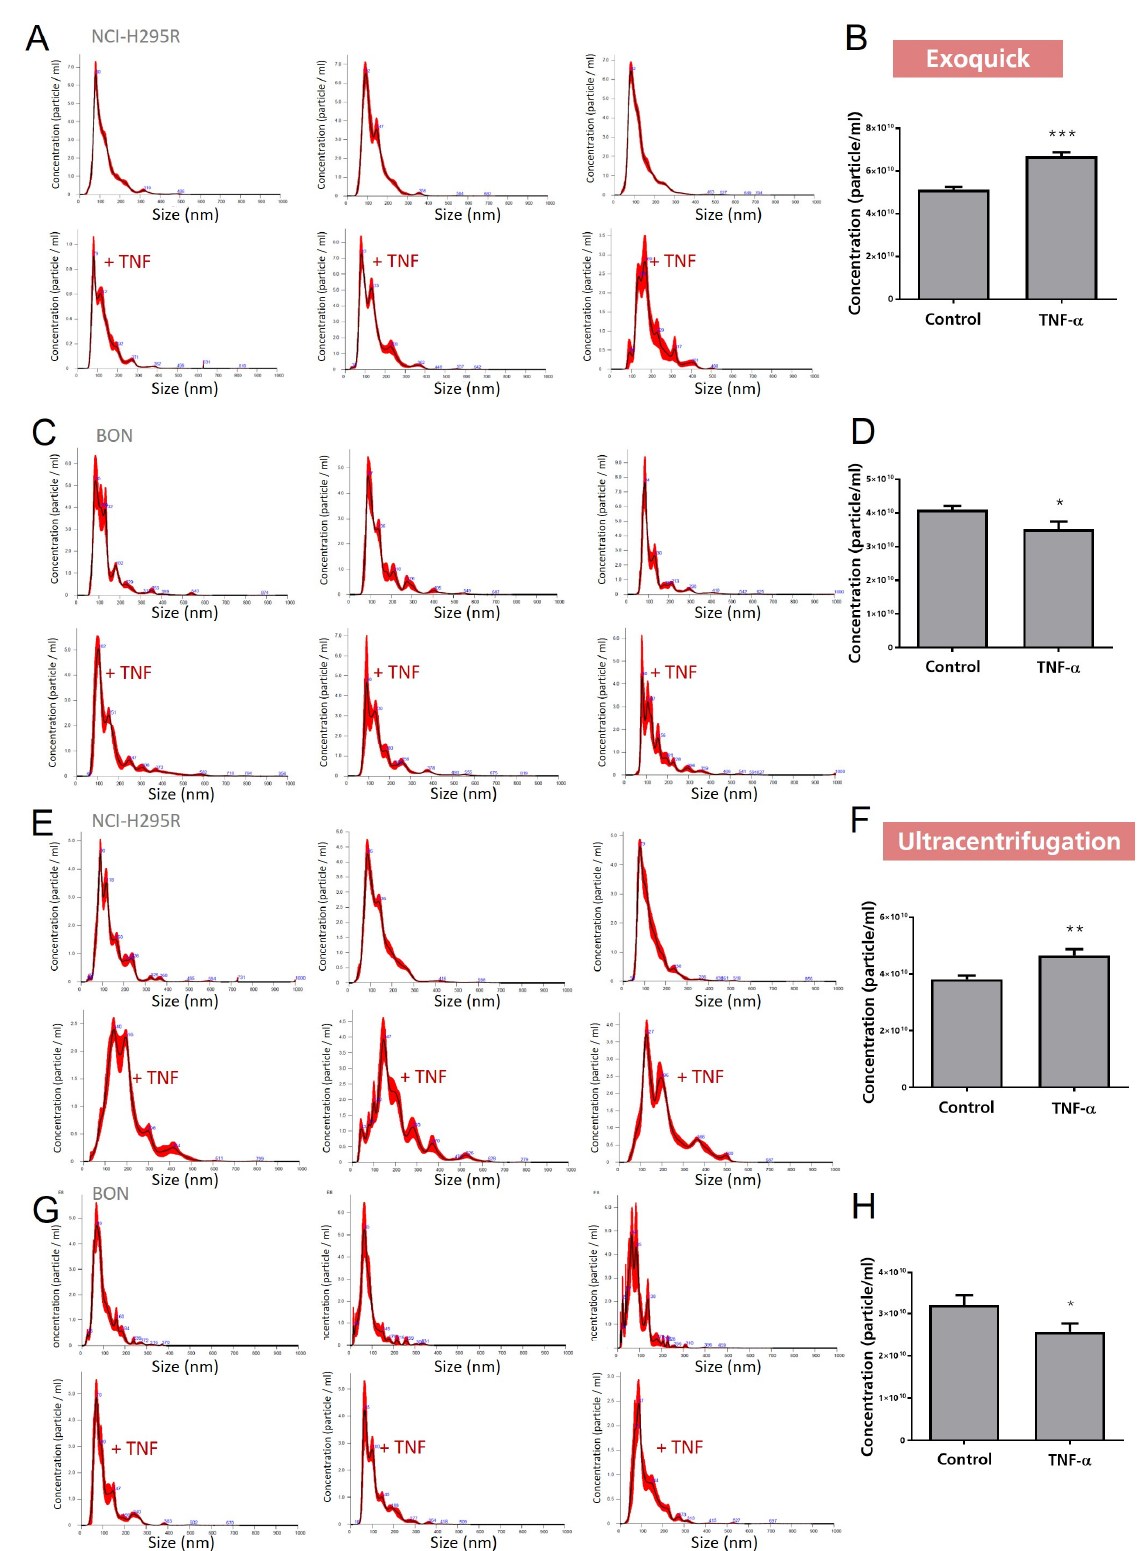
Figure 3. Nanoparticle tracking analysis including size distribution ( A , C , E , G ) and quantification of exosomes isolated by either ExoQuick ( B , D ) or ultracentrifugation ( F , H ) from cell culture supernatants of TNF α -treated BON and NCI-H295R cells. The statistical significance is based on paired t-tests vs. controls and is denoted as stars (* p < 0.05; ** p < 0.01; *** p <